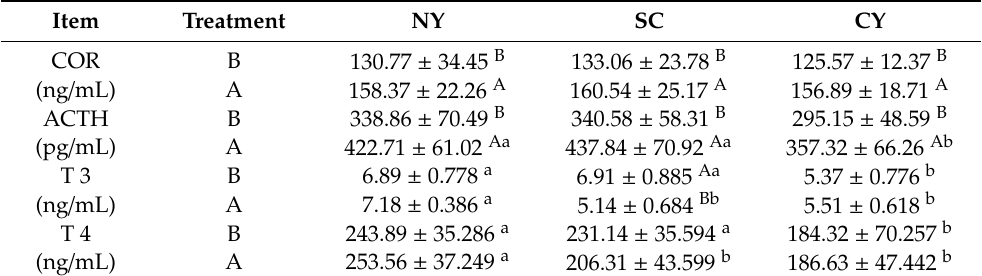
Table 1. Hormones levels before and after